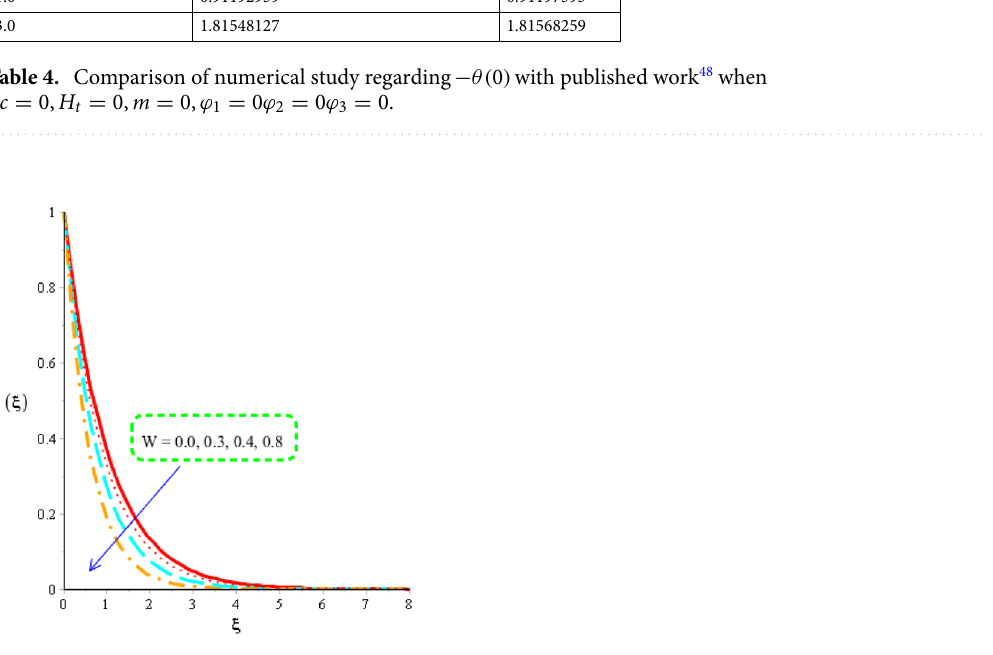
Figure 4. Distribution in velocity field versus W .